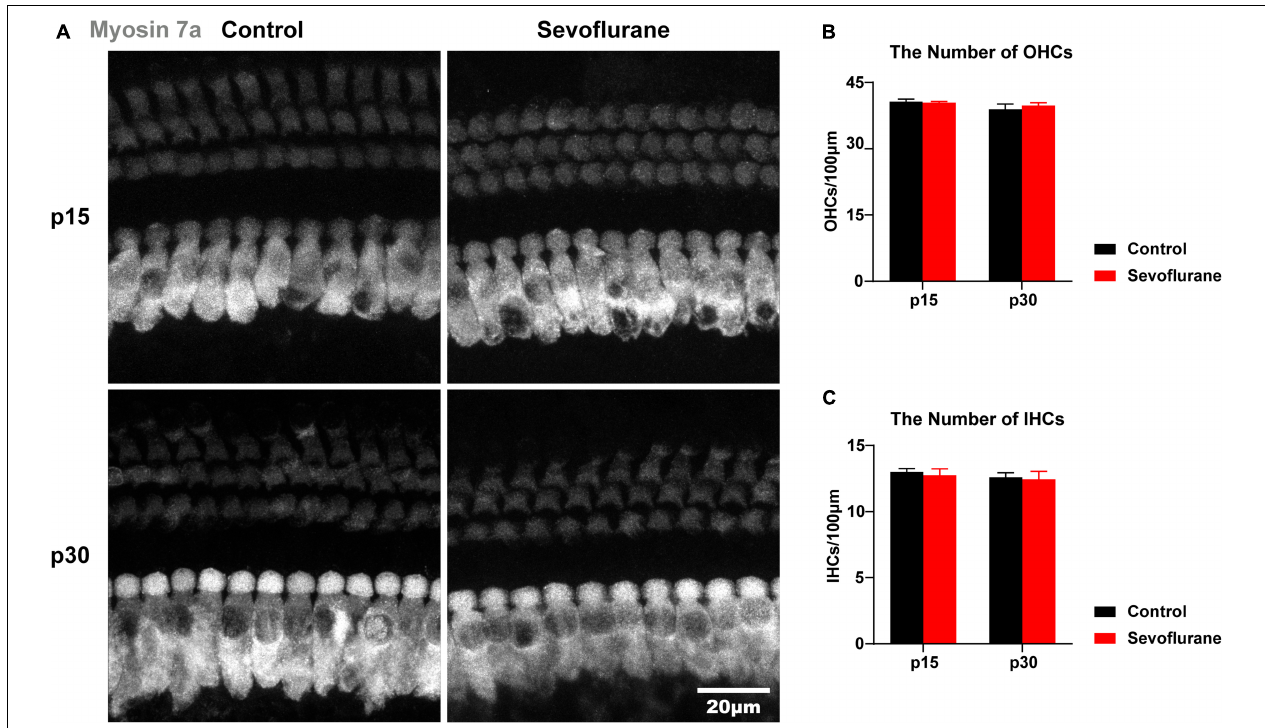
FIGURE 2 | Multiple sevoflurane exposures in naïve mice do not damage hair cells. (A) Outer hair cells (OHCs) and inner hair cells (IHCs) identified by immunostaining for myosin VIIa (gray). The morphology and arrangement of IHCs and OHCs are comparable in the two groups on P15 and P30. (B,C) Quantitative data of panel (A) ( n = 11 control group, n = 12 sevoflurane group). P > 0.05, unpaired Student’s t -test. Scale bar = 20 µ m.